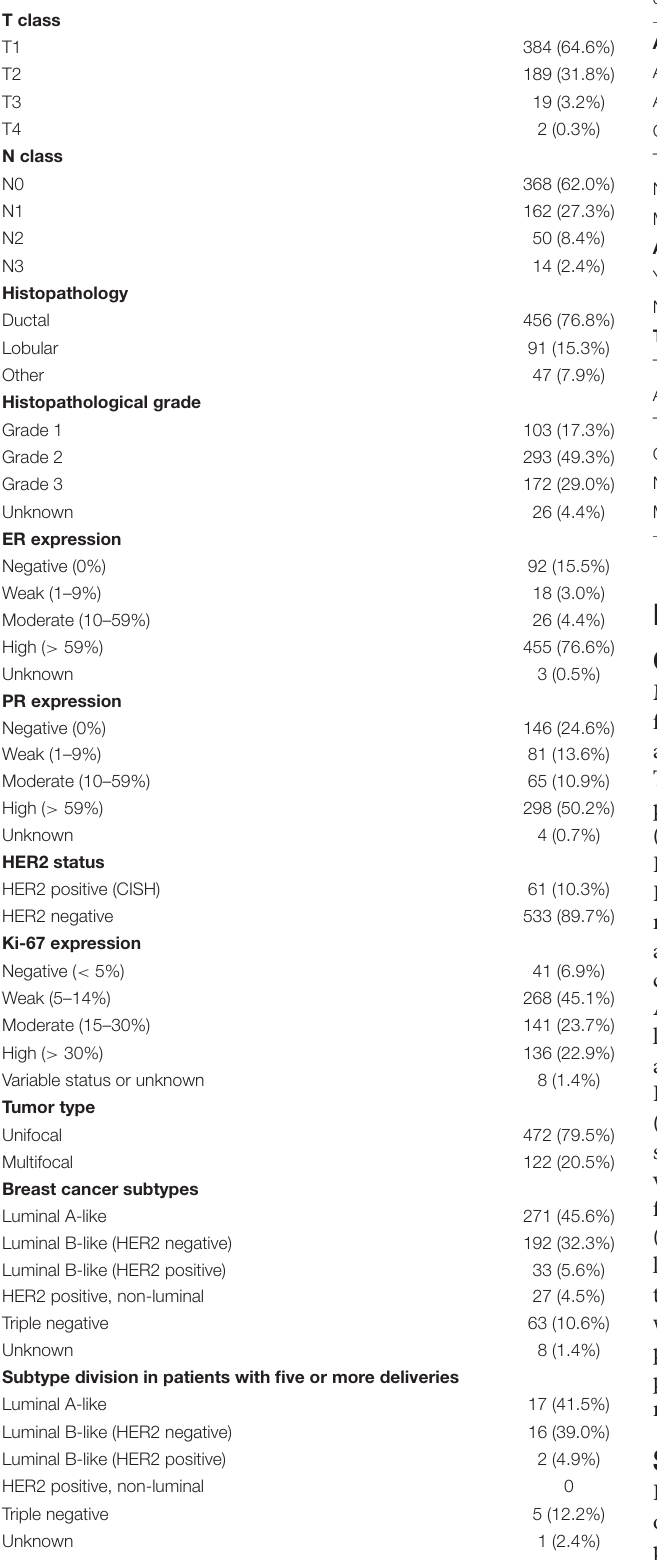
TABLE 2 | The distribution of tumor characteristics. TABLE 3 | The distribution of adjuvant chemotherapy, radiotherapy, and endocrine